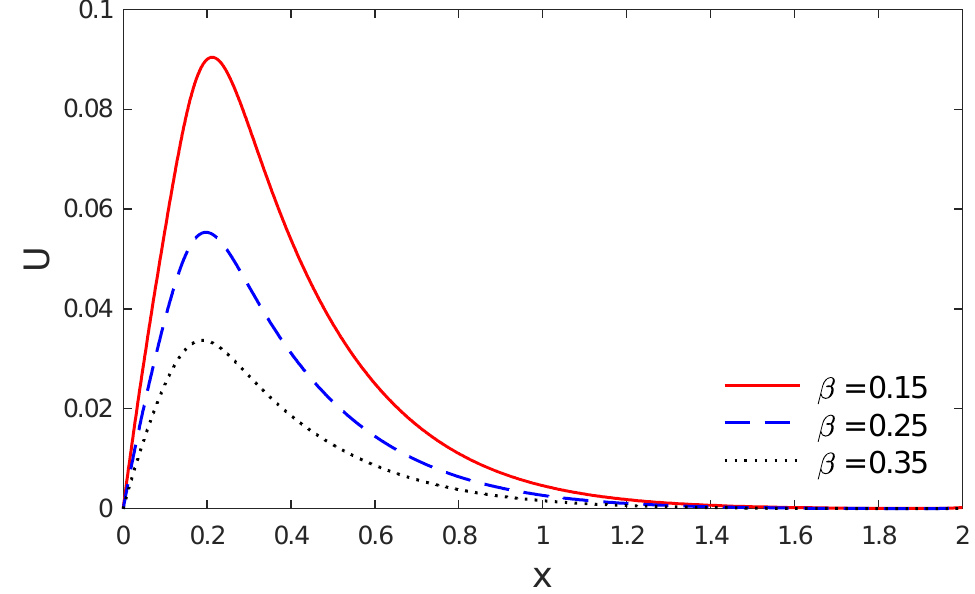
Figure 3. The variations of fluid displacement 𝑈 versus 𝑥 for several values of porosity.